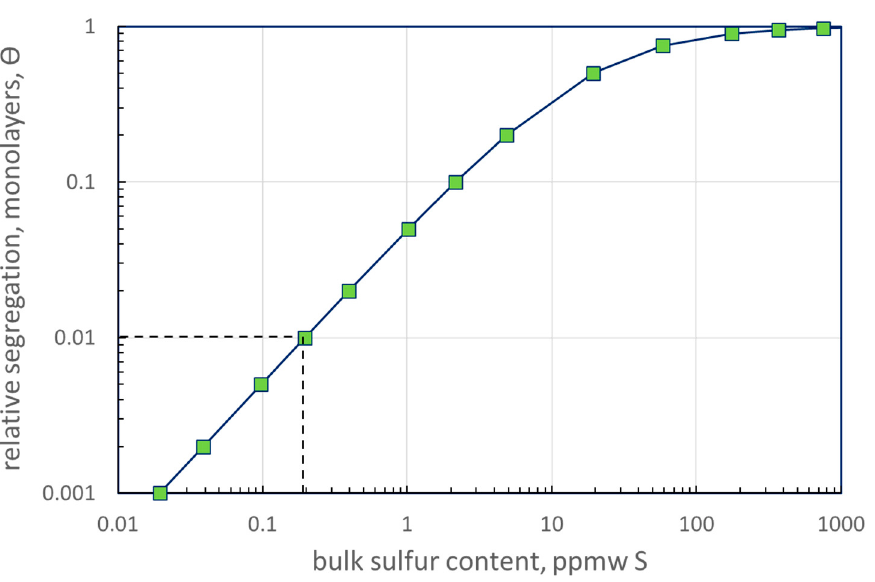
Figure 4. Projected relation between surface segregation and bulk sulfur content at 1100 °C (McLean–Langmuir isotherm, Equation (2)).